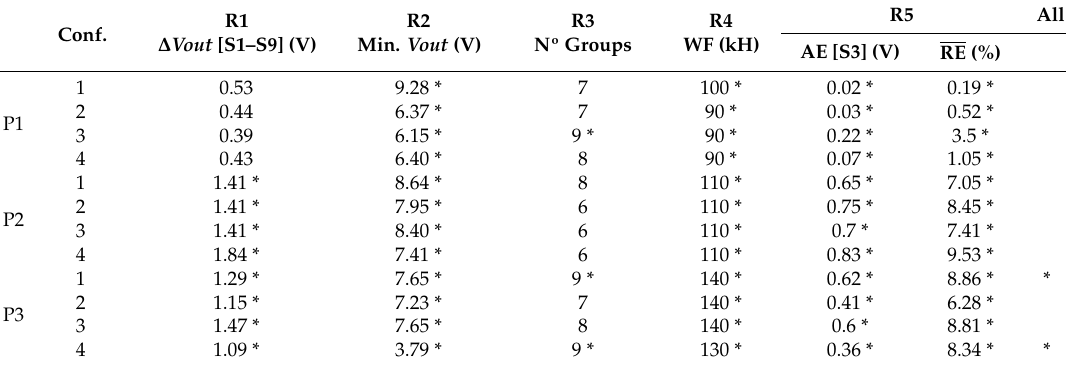
Table 6. Statistical ANOVA test to analyse measured values. The requirements to be met by the prototypes are shown so that they are optimal for measuring OF, where “P” means prototype and “R” requirement. Values with an asterisk indicate that the requirements are